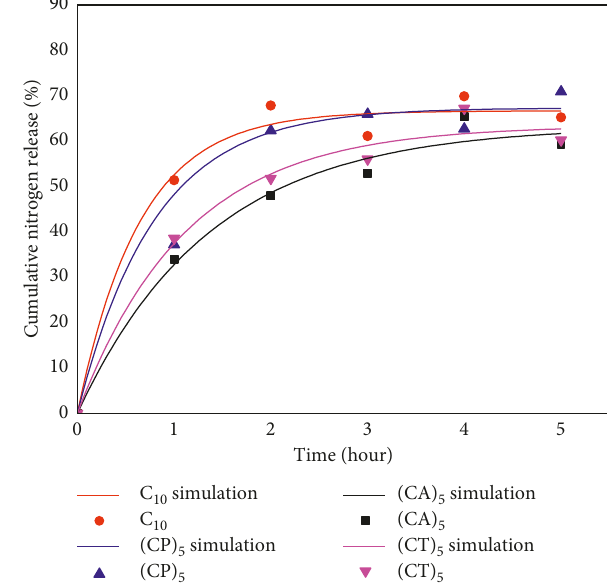
Figure 8: MATLAB simulation of nitrogen release.